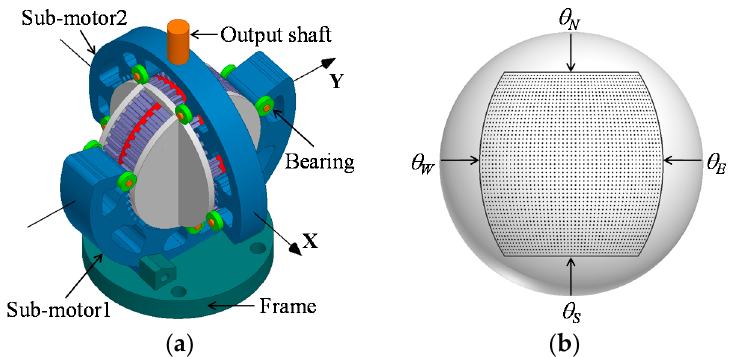
Figure 1. The developed spherical 2-DOF (two-degree-of-freedom) hybrid stepping motor. ( a ) Configuration; ( b ) Diagram of the 2-DOF motion trajectory.